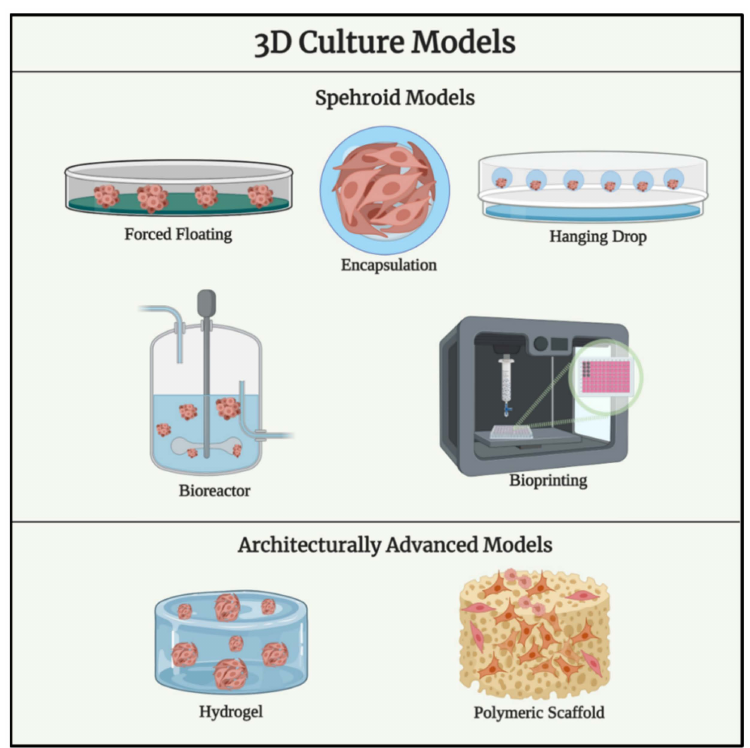
Figure 1. A graphical schematic of key techniques used for three-dimensional cell culture (created on BioRender.com (accessed on 14 March